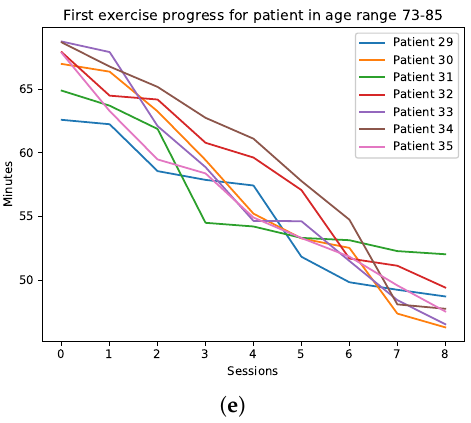
Figure 11. The performance of the patients for the first exercise. The plots are divided by age: ( a ) 25–36,